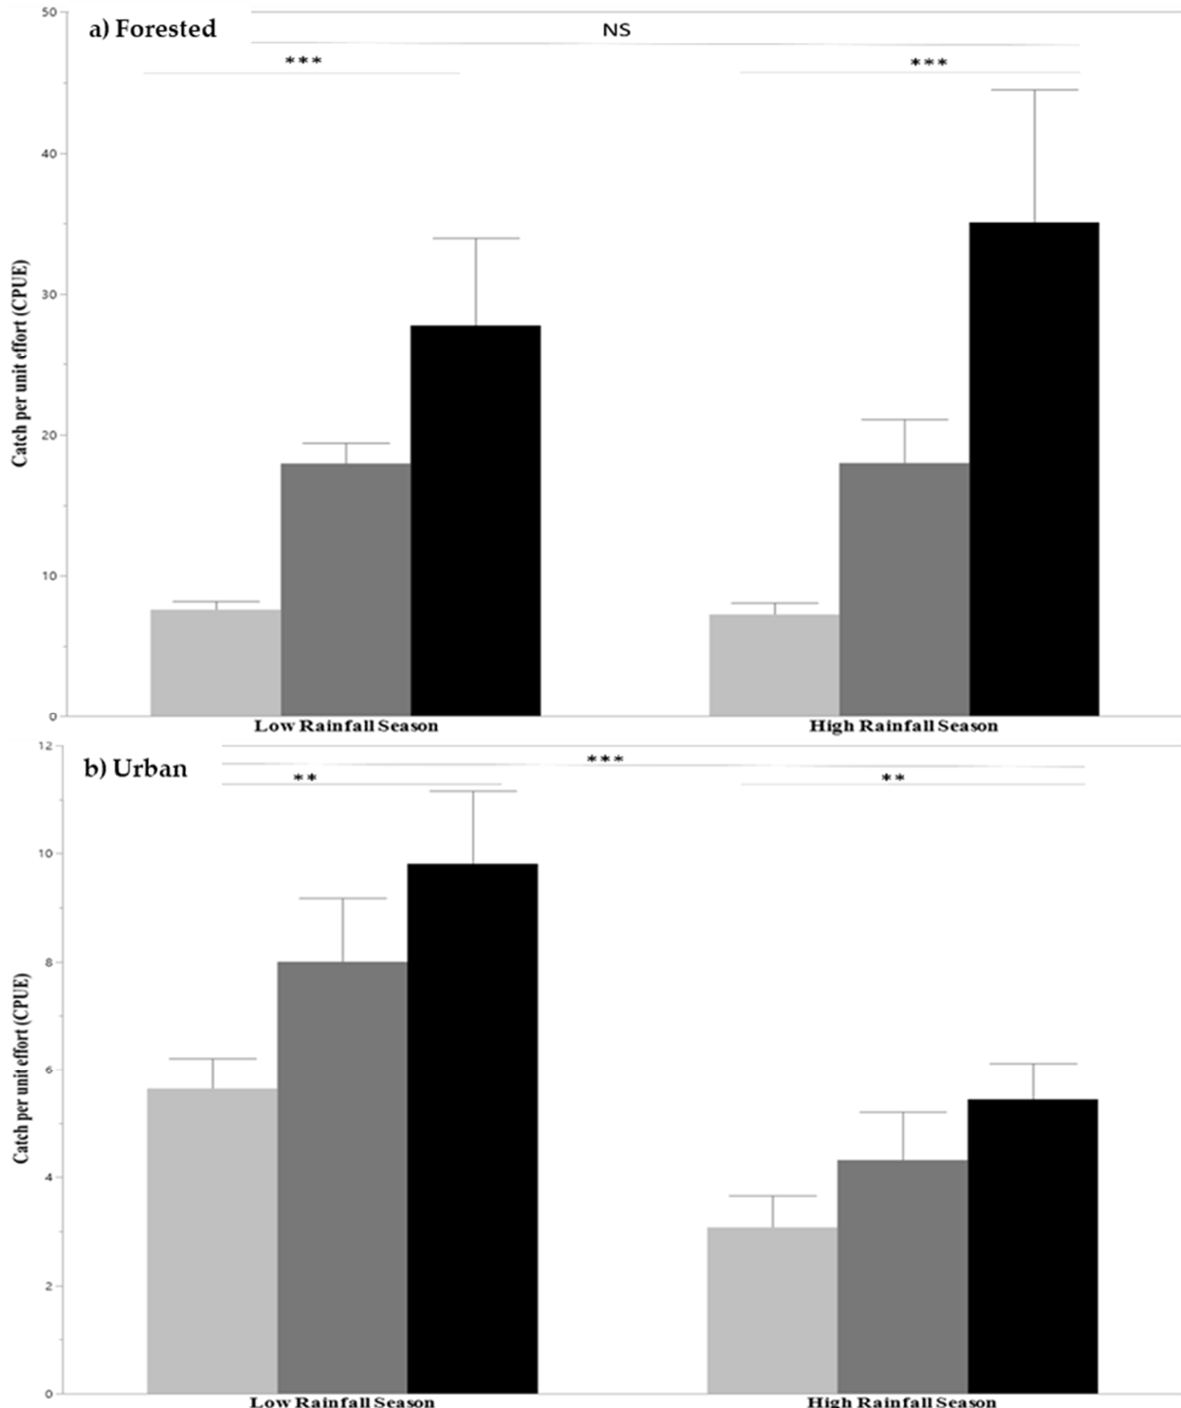
Figure 3. The mean ( ± SE) catch per unit effort (CPUE) for Xiphocaris elongata during LRF (low rainfall) and HRF (high rainfall) seasons. ( a ) Forested watershed (Rio Sabana) and ( b ) urban watershed (Río Piedras). Light grey bars represent HU (high urban), grey bars the MU (medium urban), and black bars the LU (low urban) reaches, respectively. The horizontal line over the bars represents the two-way ANOVA test differences NS—not significant; ** p < 0.01; *** p < 0.001.